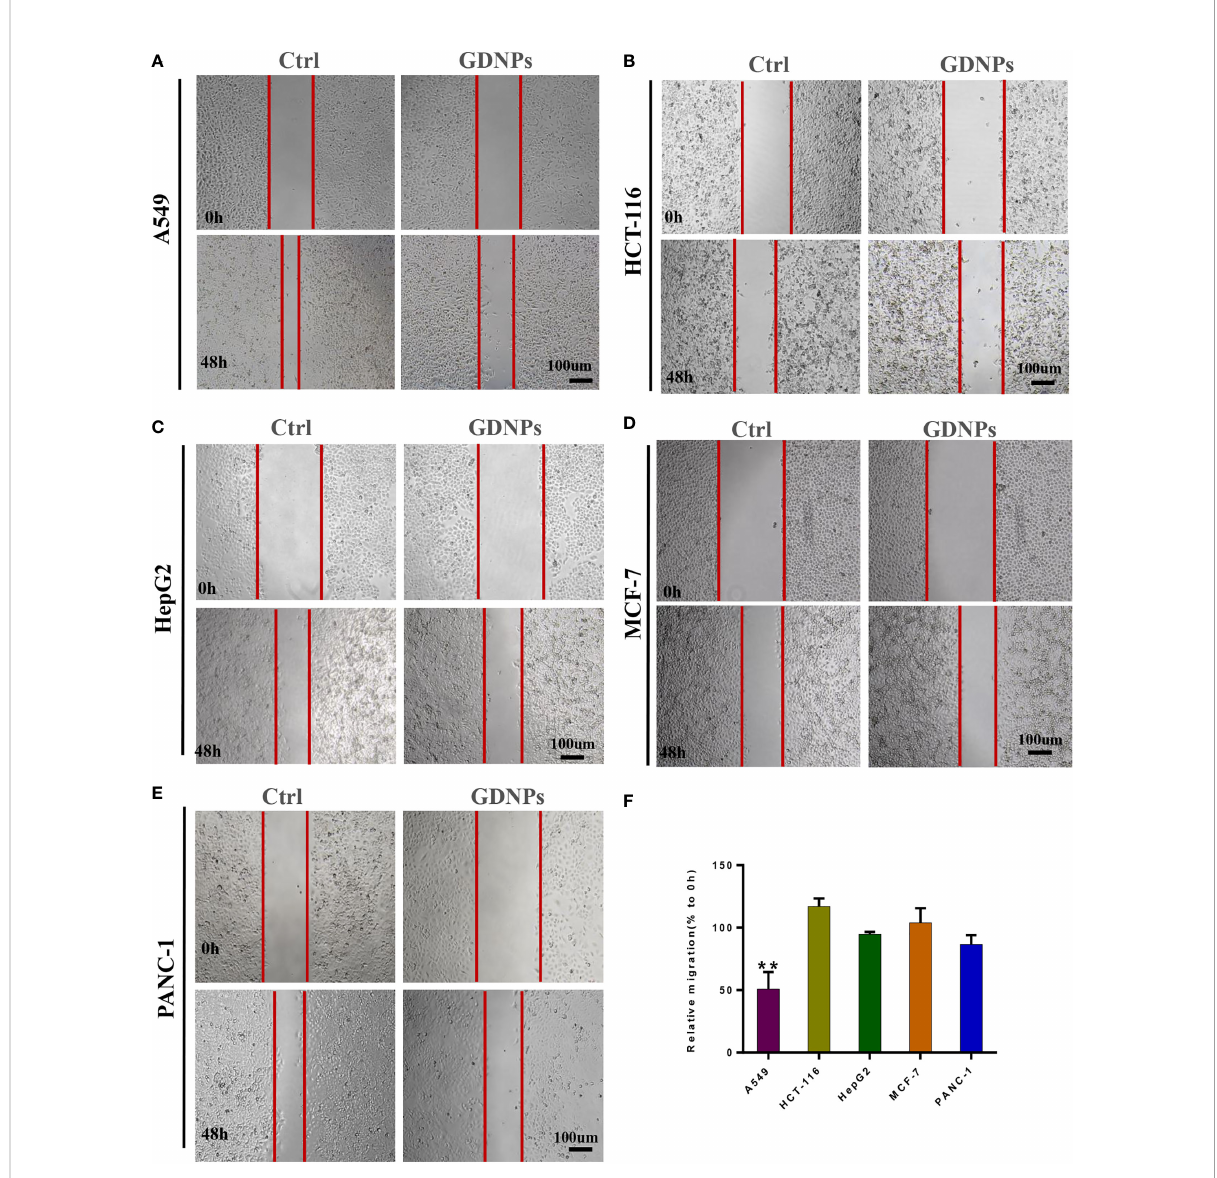
FIGURE 2 Effect of GDNPs on cancer cell migratory ability. (A) Analysis of A549 cells via wound-healing assay. (B) Analysis of HCT-116 cells via wound-healing assay. (C) Analysis of HepG2 cells via wound-healing assay. (D) Analysis of PANC-1 cells via wound-healing assay. (E) Analysis of MCF-7 cells via wound- healing assay. Images were acquired at 0 and 48 h. (F) Quantitative analysis of wound-healing assay data. Images were captured at 0 h and 48 h after wound formation, then the mean (%) change in width of the wound during healing was calculated by comparing wound width after 48-h healing (closure) to wound width at 0 h. Data are presented as the mean ± SD of three experiments (*P <